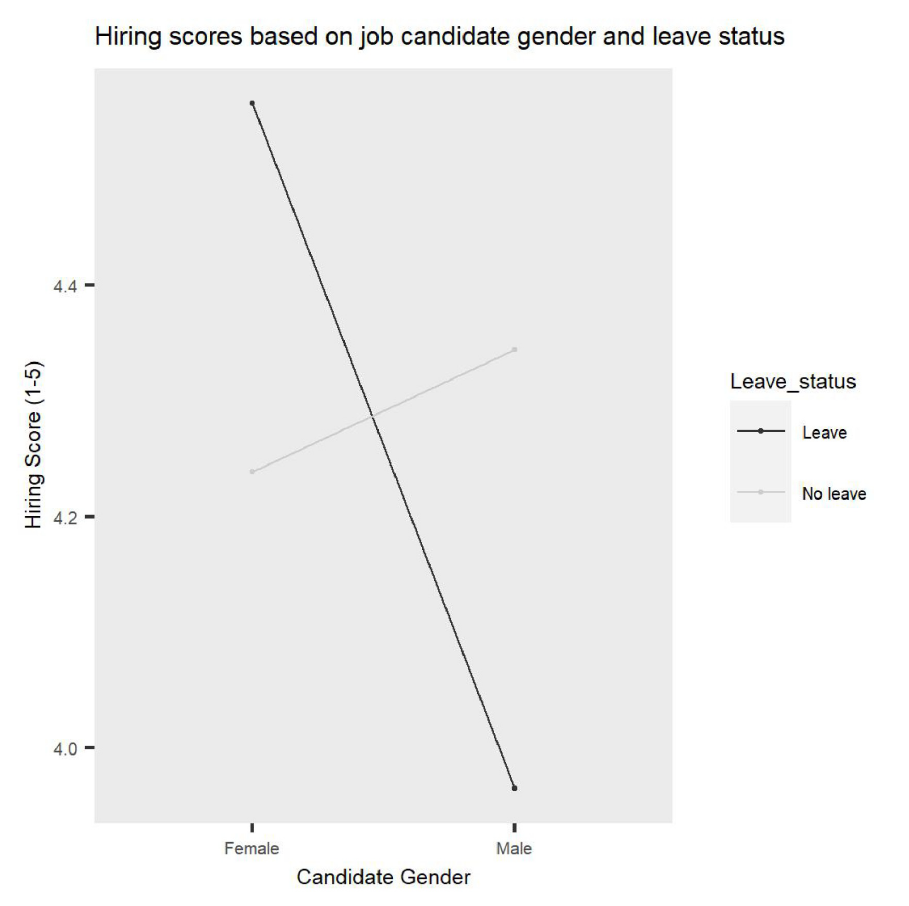
Fig 4. A significant interaction between candidate gender and candidate leave status. Hiring ratings vary significantly based on job candidate gender and leave.